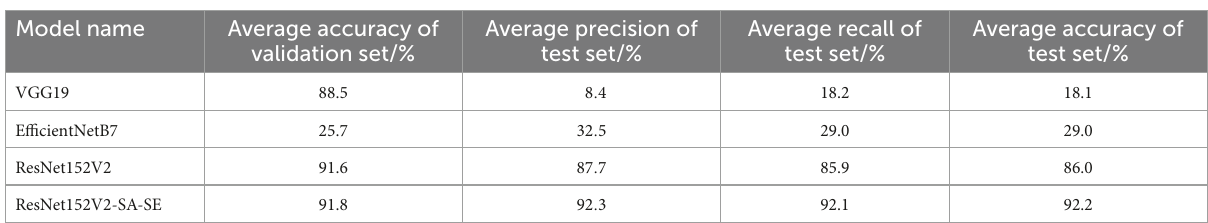
TABLE 6 Test results of the four types of